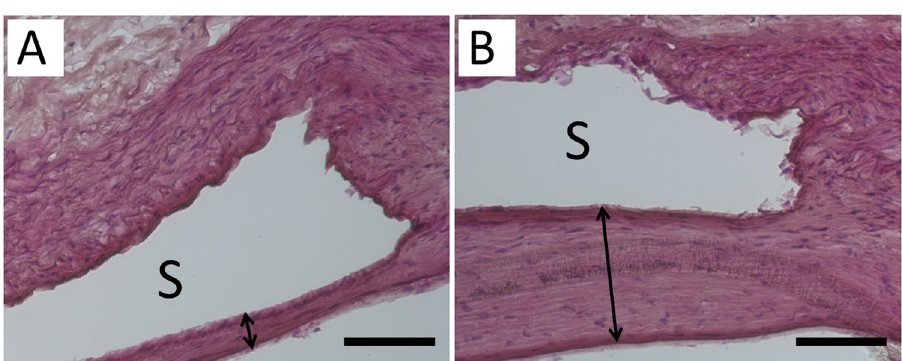
Figure 10. By weeks 24, group A exhibited re-constituted endothelium with insignificant intimal hyperplasia ( A ) however, group B showed substantial intimal hyperplasia with a thickness of around 70 μ m ( B ) (double arrow). (Scale bar = 50 μ m) (S: stent